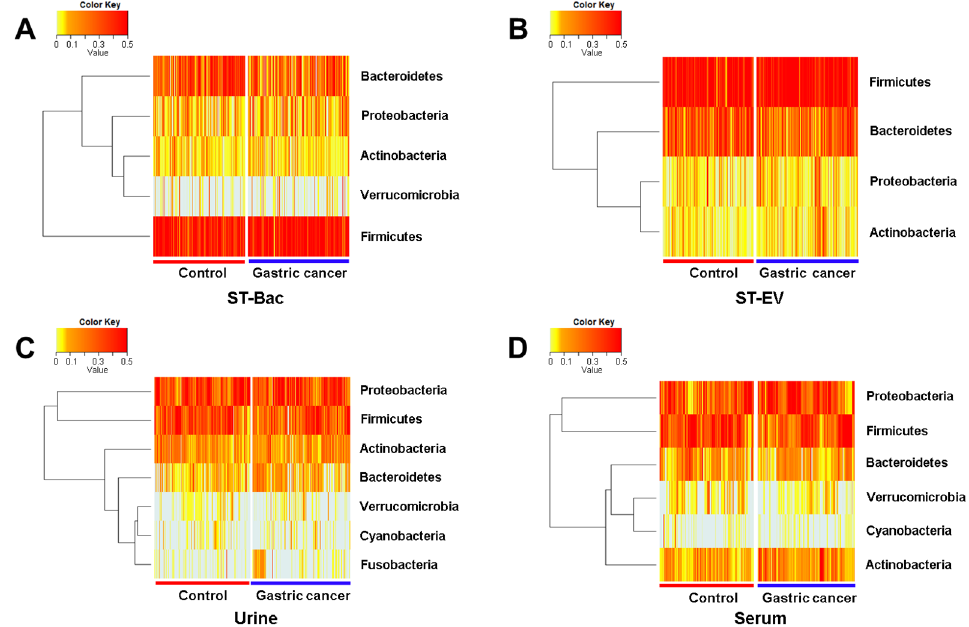
Figure 3. Relative abundance differences in phylum level between healthy controls and gastric cancer patients in 4 sample types. Heatmaps representing the relative abundances of microbiome between the two groups ( A ) in stool bacteria (ST-Bac) isolated from stool pellet, ( B ) in stool-derived extracellular vesicle (ST-EV) isolated from stool supernatant, ( C ) in urine, and ( D ) in serum.